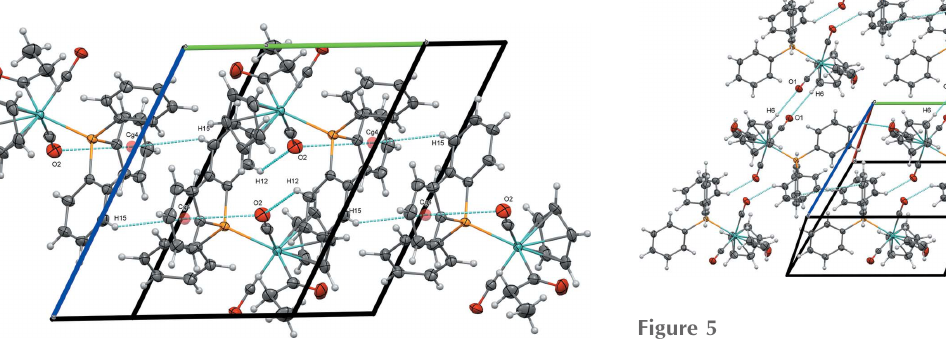
Figure 4 Chains of ( 1 ) along [010], viewed along [310].